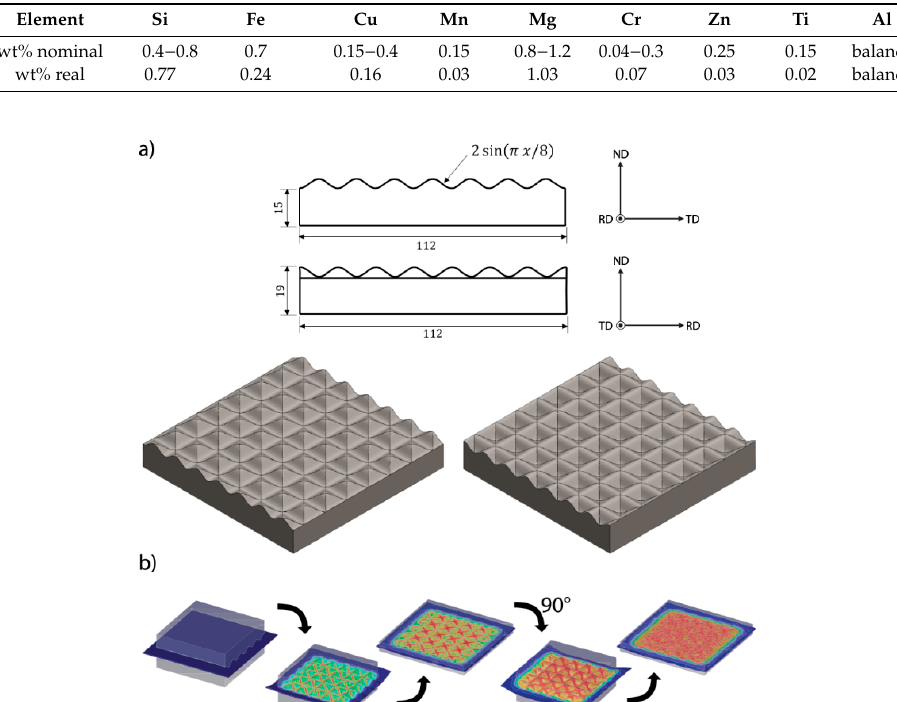
Table 1. Composition of the Al-6061 alloy obtained by X-ray fluorescence.